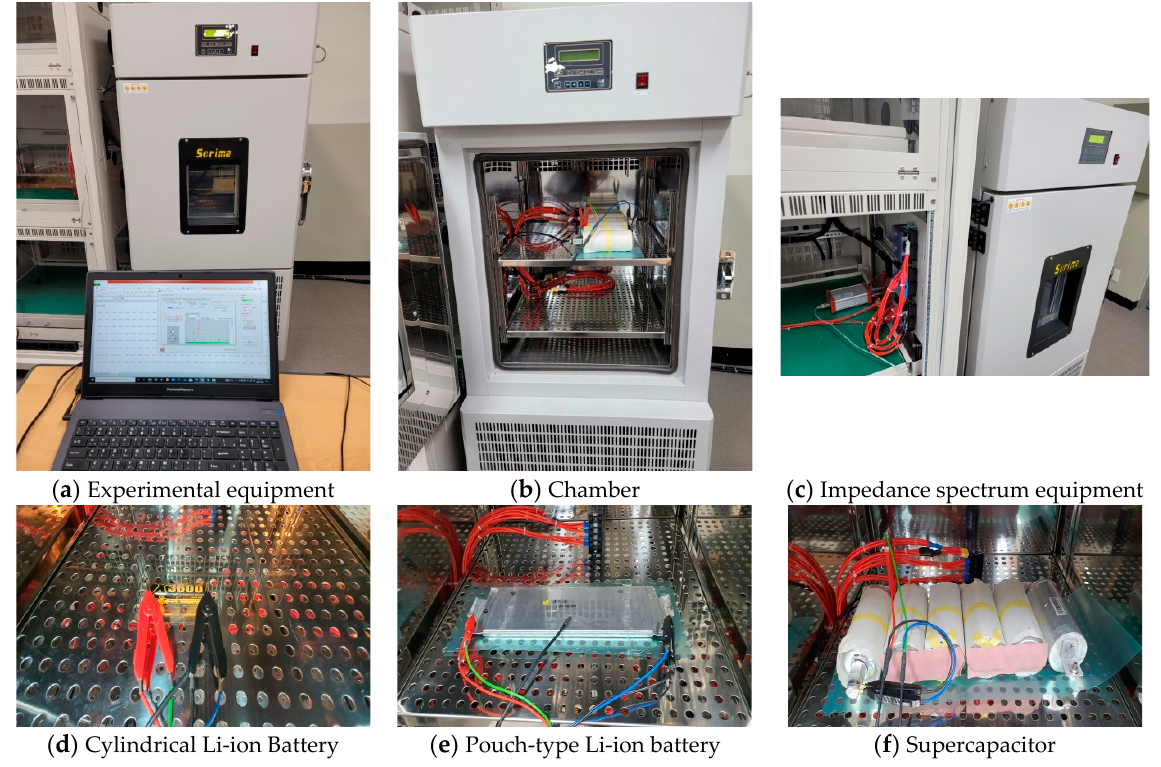
Figure 15. Experimental apparatus.